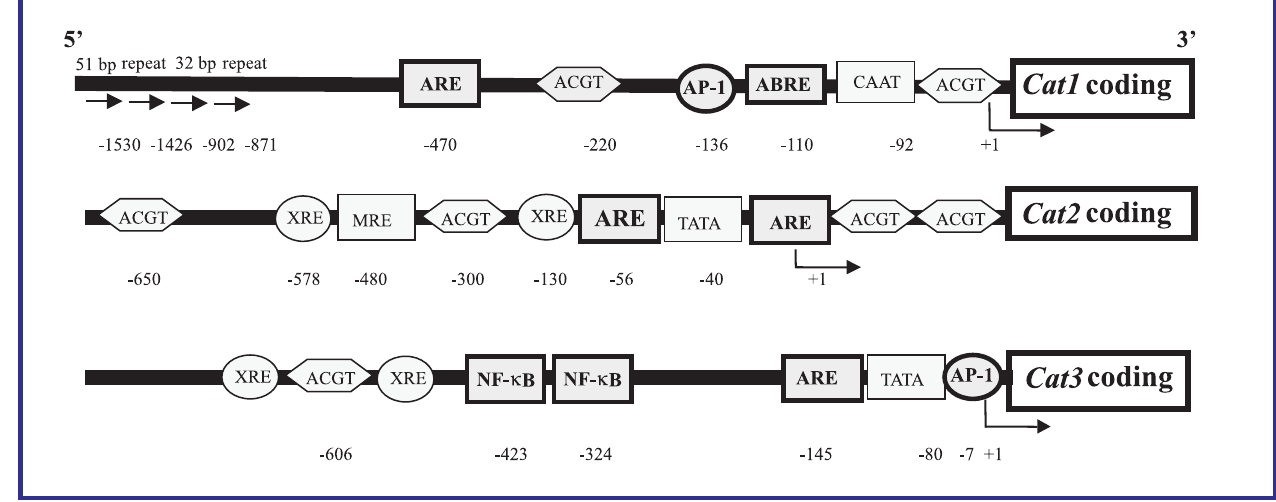
Figure 9. Convergence of vari- ous biotic and abiotic stress stimuli onto mitogen-activated protein kinase (MAPK) path- ways via reactive oxygen spe- cies (ROS) as a common factor, leading to activation of antioxi- dant defense genes. Alternative pathways have also been impli- cated. MAPKKK = MAPK kinase